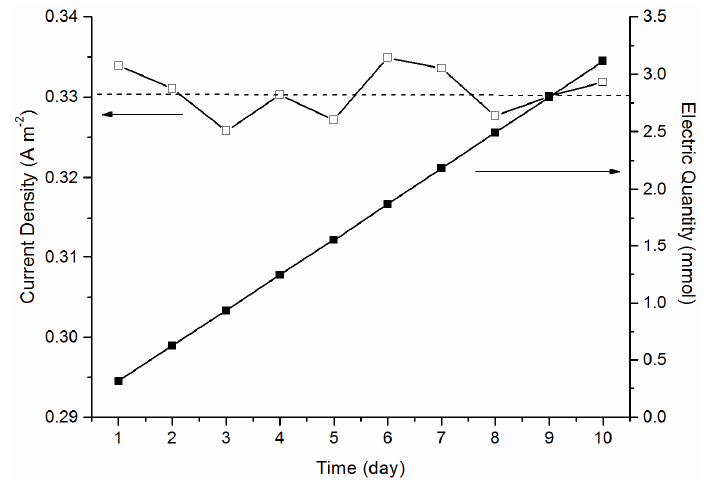
Figure 3. Stable system current density at 1000 Ω for 10 days (one typical batch cultivation) in the MFC with natural hematite cathode. Solid symbols indicate electric quantity, open symbols indicate current density, and dashed line is average value of 10 days’ current density data.